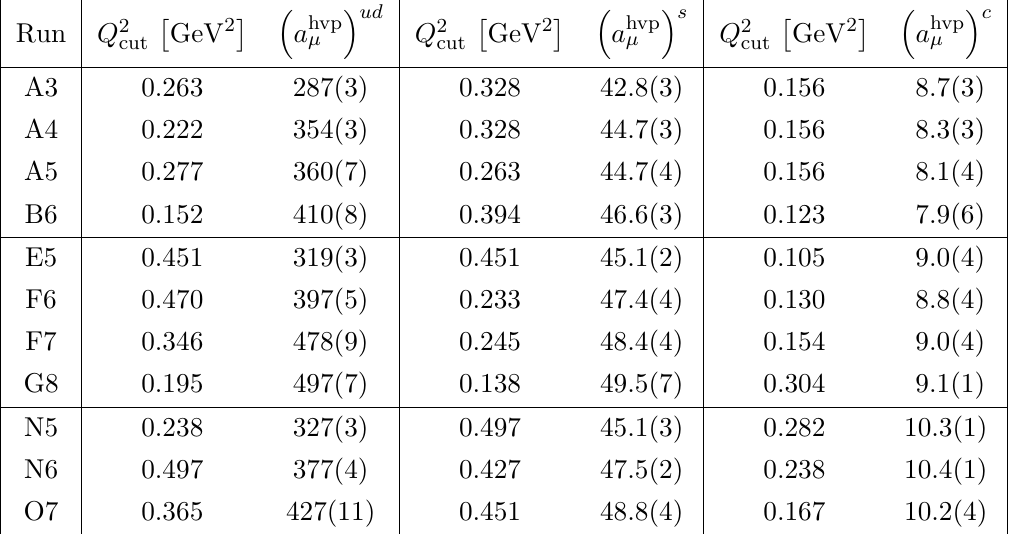
(in units of 10 (cid:0) 10 ) determined via (cid:22) the VPF is represented by a Pad(cid:19)e [1,1] constructed from the cut